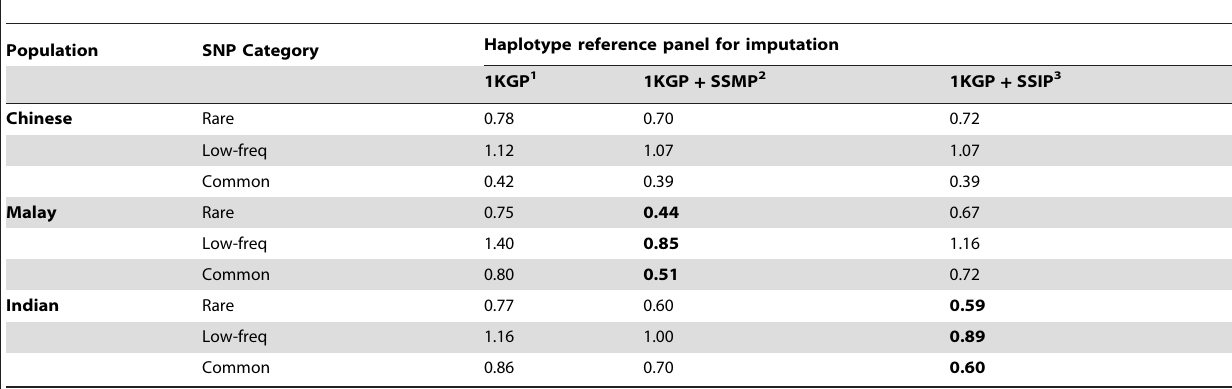
Table 1. Discordance (%) between imputed genotypes and actually observed genotypes at SNPs on Omni2.5 but not in the exome chip.